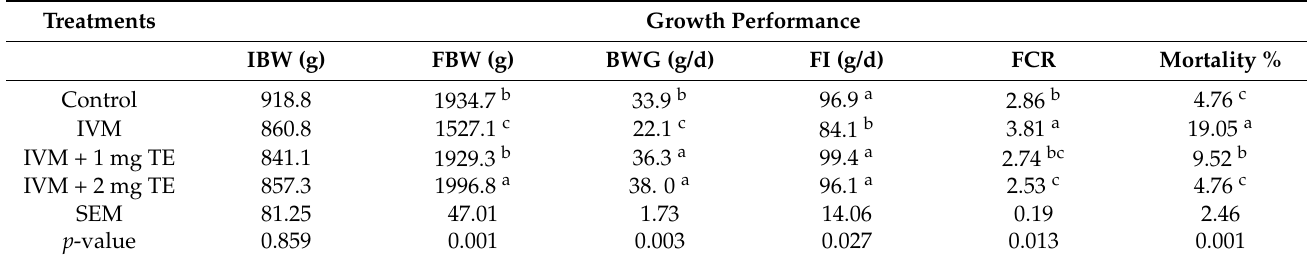
Table 2. The effect of combining of Ivermectin injection with turmeric extract supplementation on rabbit growth performance. Treatments Growth Performance